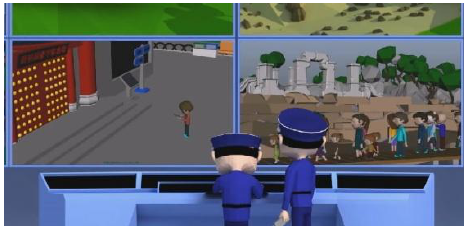
Figure 6: Sensing and monitoring information to achieve real-time control